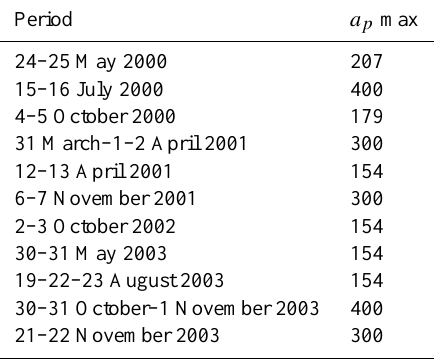
Table 1. Periods chosen to test IFELMOR and STORM models. Period a p